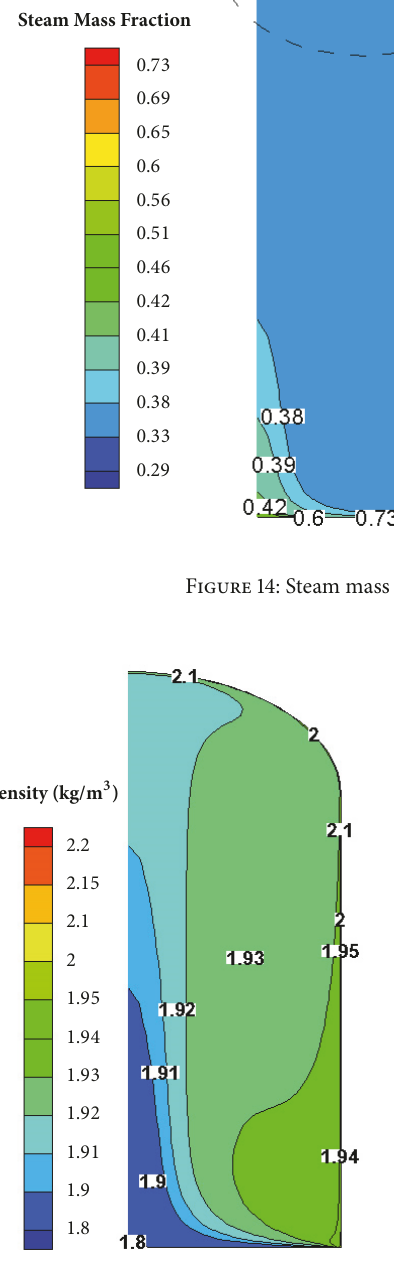
Figure 15: Density contour in the AP1000 containment. the steam diffusion and decreasing the buoyancy force. For natural convection, buoyancy force is very important. The operation pressure is 0.2565 MPa, the temperature of bottom evaporation wall is set as 395 K, the temperature